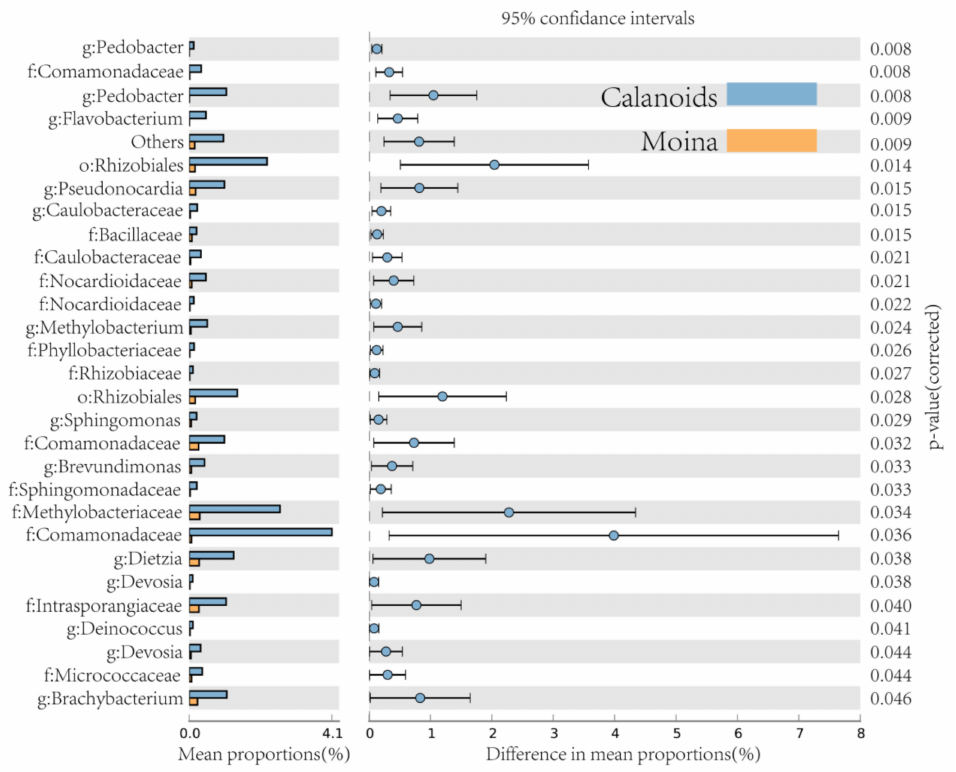
Figure 3. Significantly different OTUs between microbial communities associated with Moina and Calanoids in five freshwater lakes. Mean proportion of each OTU and the highest taxonomy level was listed in the left panel where “o”, “f”, and “g” respectively represent order, family, and genus. Significance ( p − value < 0.05) is shown in the right panel.